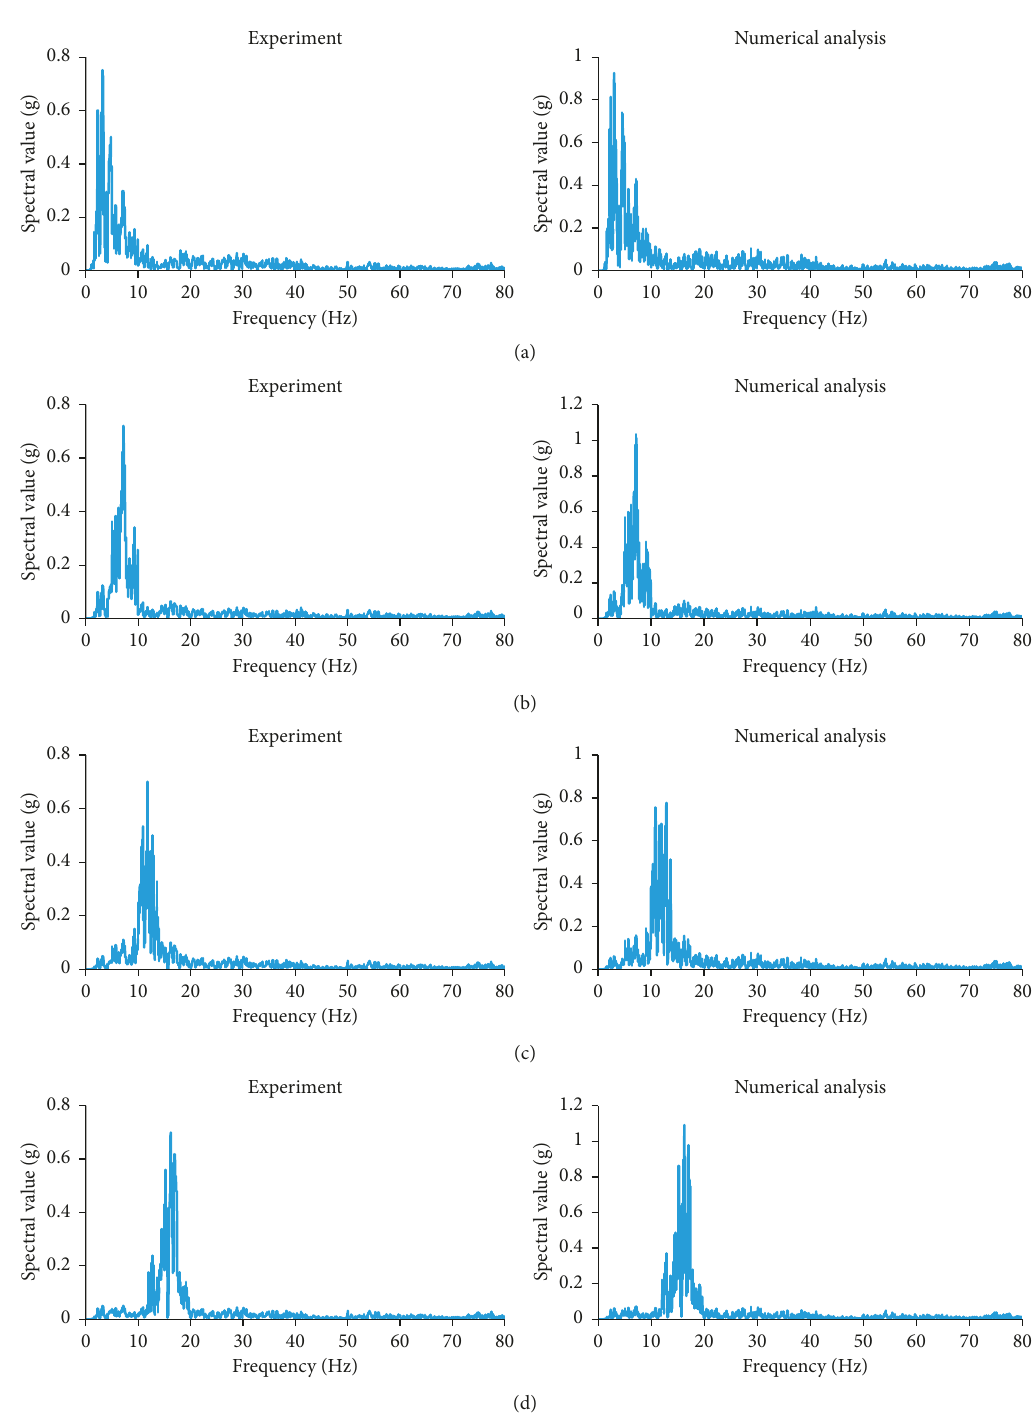
segment shown in Figure 10, the “upper skeleton curve” rule in the extended Masing rule will be applied, in which the subsequent stress-strain curve will be exchanged into the skeleton curve, such as the 2-1-3 ′ curve segment been corrected to 2-1-3 curve shown in Figure 10.